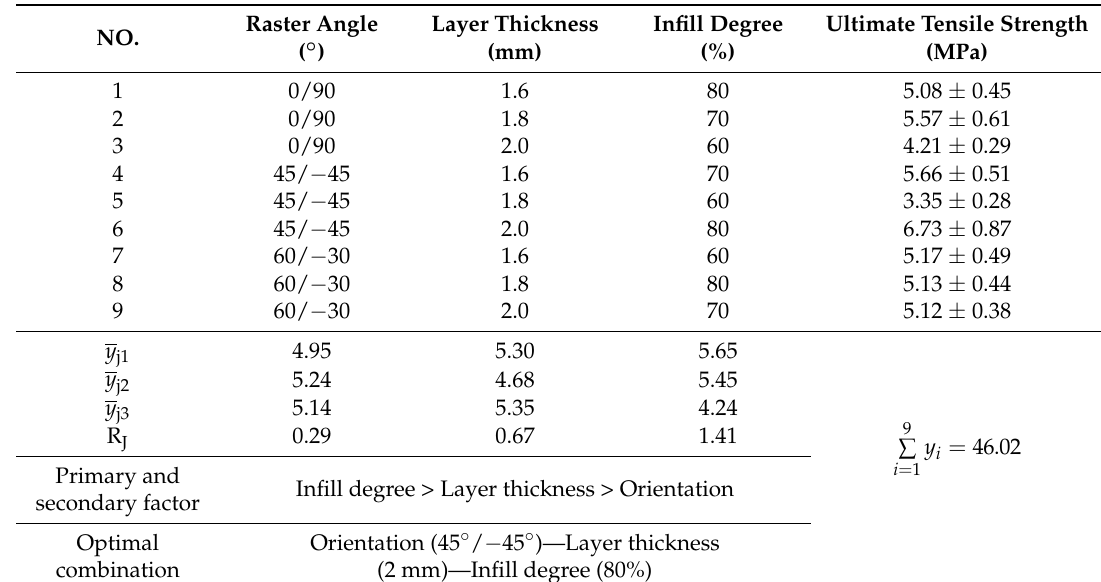
Table 6. Orthogonal table of the printing